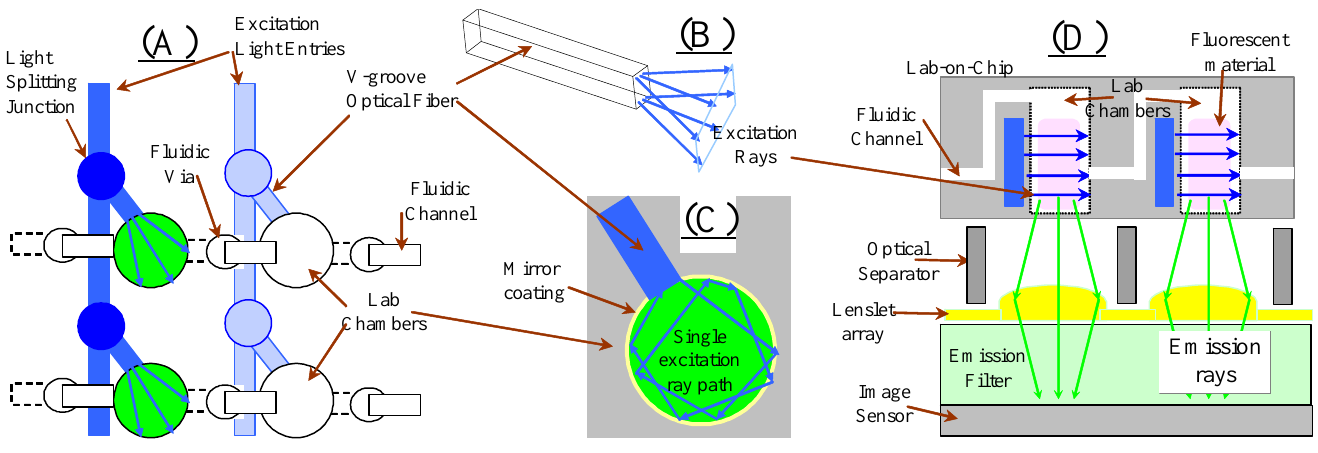
Figure 1. Side illuminated fluorescence imaging lab-on-chip